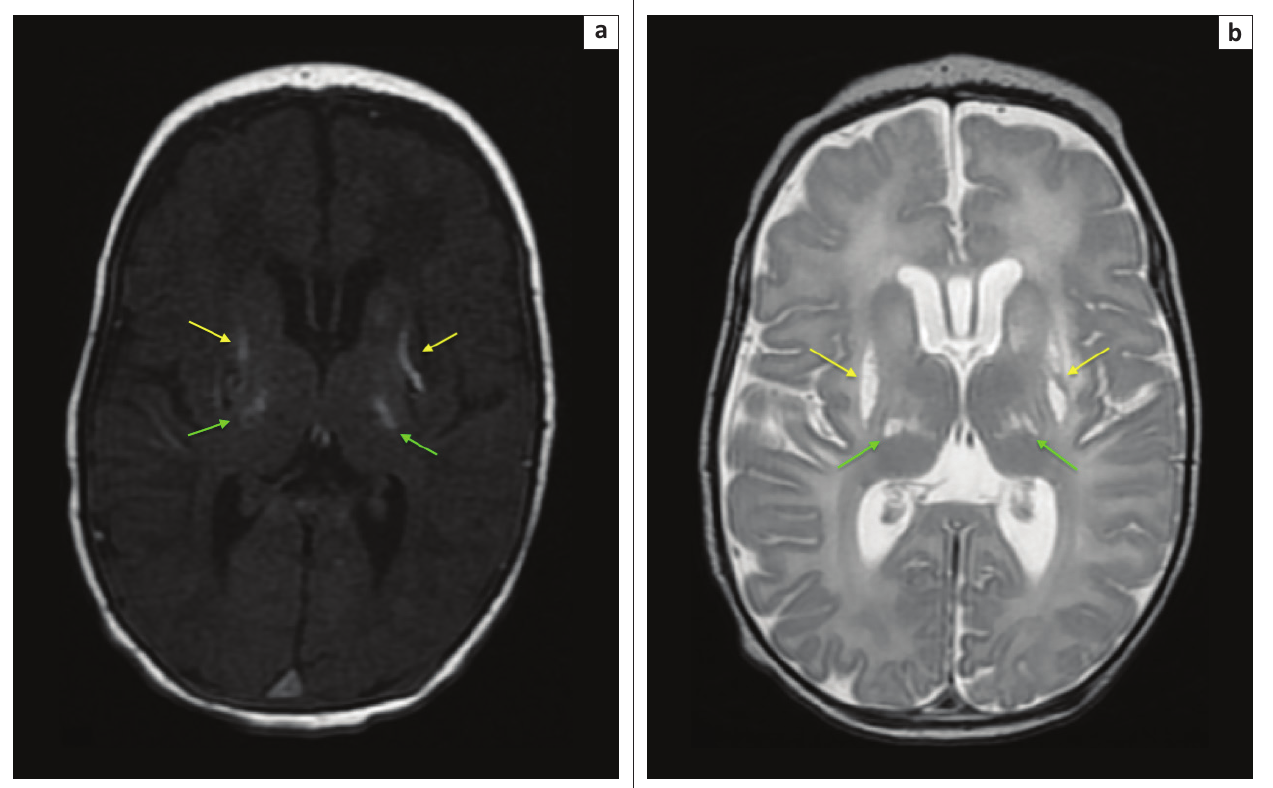
FIGURE 6: Twenty-seven-day-old male child delivered after abruptio placentae. Axial magnetic resonance imaging images at the level of the basal ganglia demonstrating bilateral fairly symmetrical dorsal putaminal (yellow arrows) and ventral thalamic (green arrows) hyperintensity because of T1 shortening (a) and corresponding T2- weighted hyperintensity and established atrophy of these structures (b). Note that the changes have evolved within the first month of